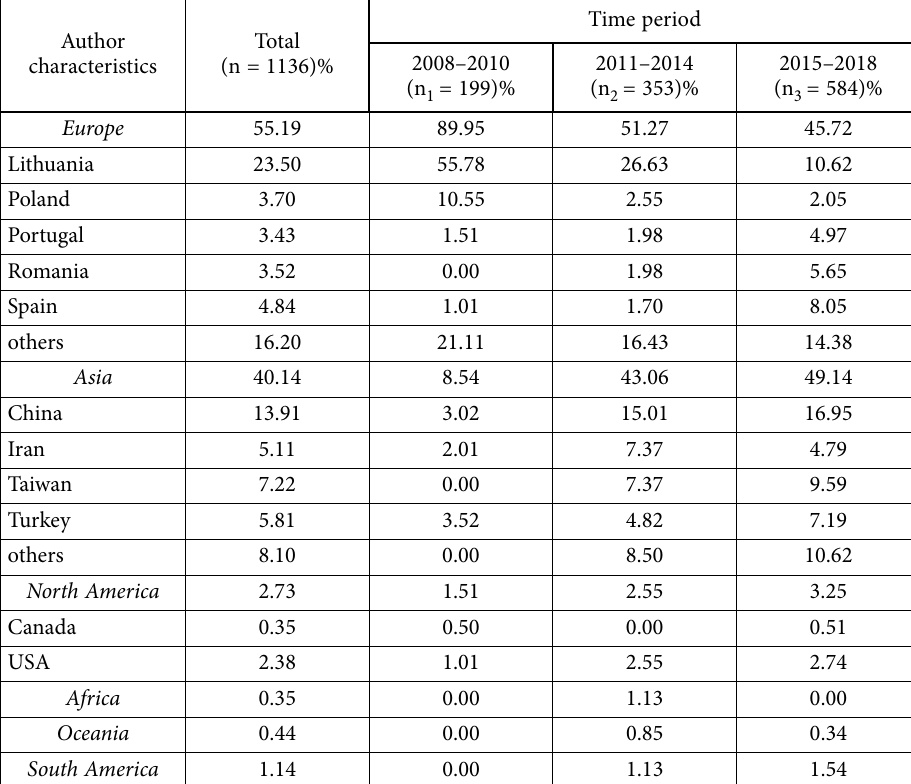
Table 3. Location of authors of the TEDE